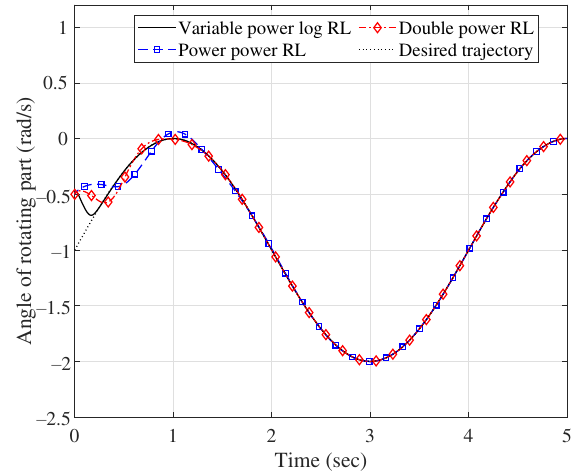
Figure 13. Angle of rotating part (Group 2). The black solid, blue dashed, and red dash-dotted lines correspond to the case of the control with variable power log, power, and double power reaching law, respectively; the black dotted line indicates the desired trajectory. The motion response of the lifting